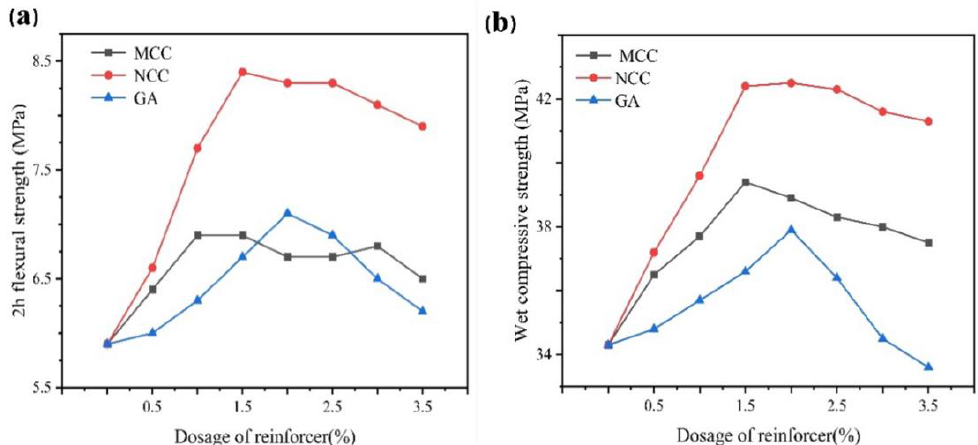
Figure 10. The effect of NCC, MCC, and GA on the mechanical strength of dental gypsum at different dosages (ww − 1 ) ( a ) 2 h flexural strength, ( b ) wet compressive strength.